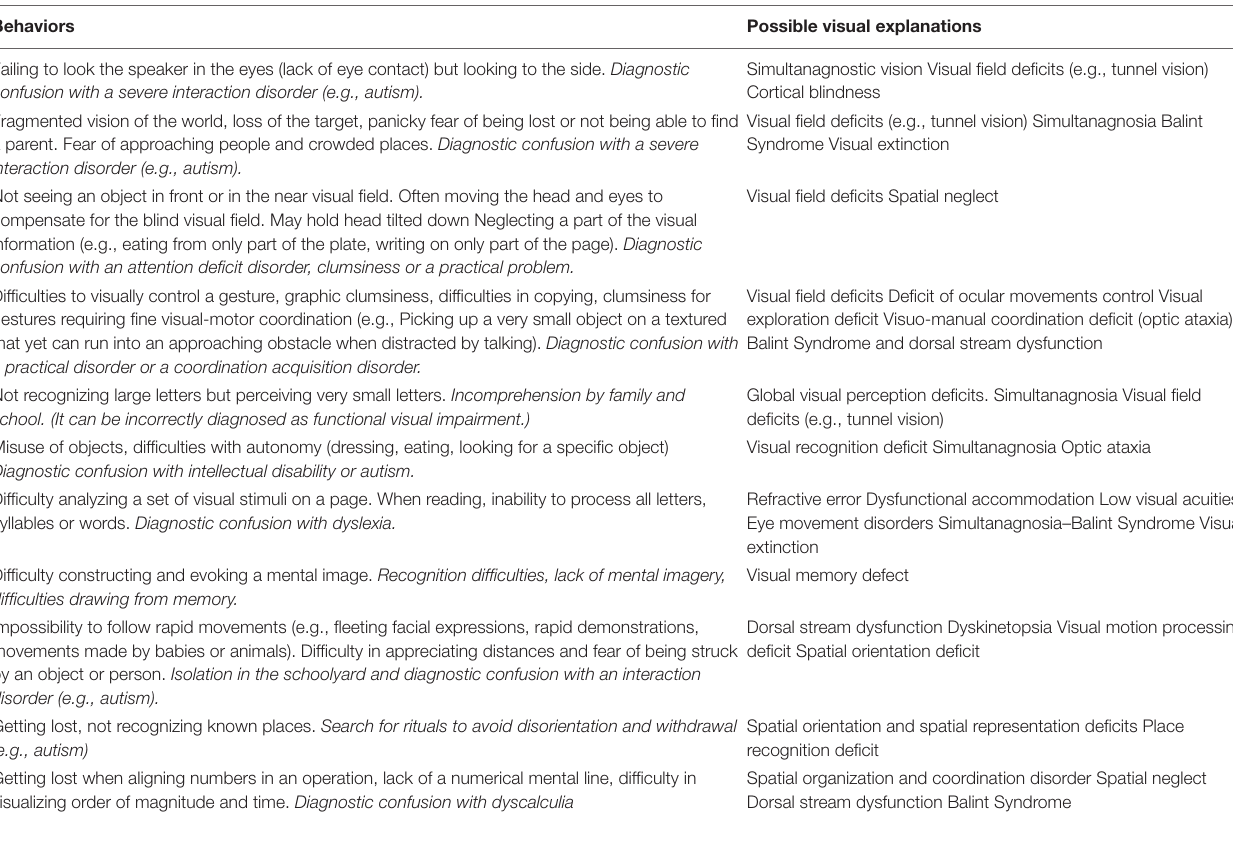
TABLE 1 | Main behavioral expressions of CVI in